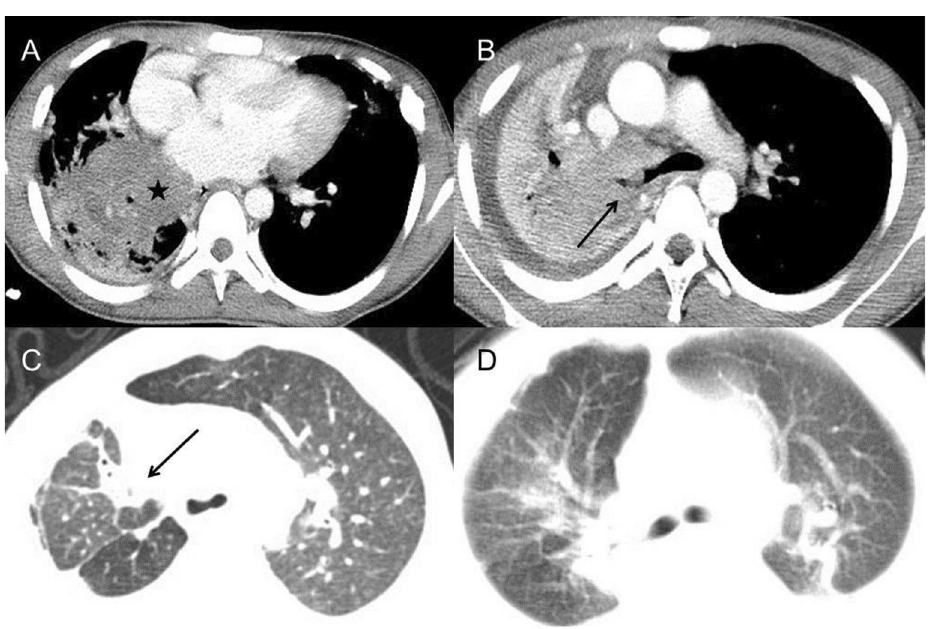
Figure 5. Pulmonary CT of TB infection. ( A , B ) 16-year-old boy with TB infection. ( A ) Post-contrast CT showed a large mass in the right lower lobe, about 5 cm in diameter (star). Multiple small cavities were found in the adjacent area of consolidation. ( B ) A nodule in the right bronchus led to atelectasis of the right lung, which was identified as TB granuloma formation by bronchoscopy (long arrow). The right pleural effusion was also found. ( C ) In a 3-year-old boy, axial CT scan showed scarring, segmental atelectasis and volume loss in the right upper lobe (long arrow). Slight bronchiectasis could be found inside the area of consolidation. ( D ) Segmental consolidation in bilateral upper lobes with adjacent ground-glass opacity were found in a 2-year-old